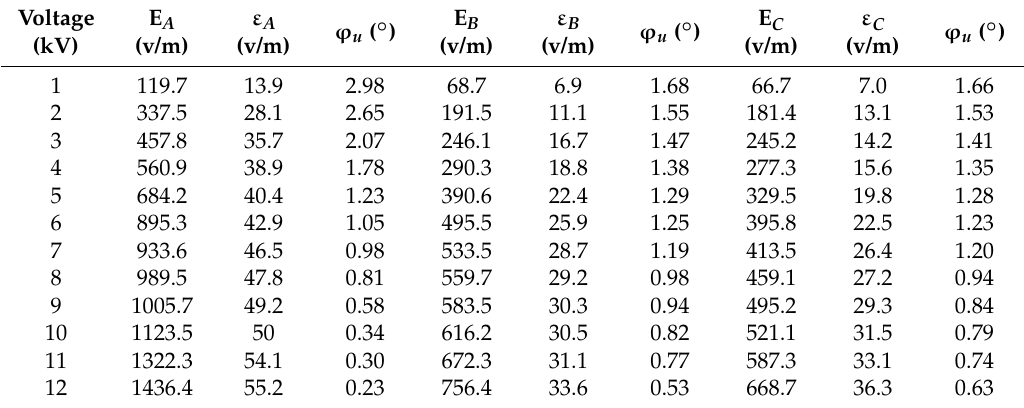
Table 1. Measurement results of electric field intensity under different voltages.